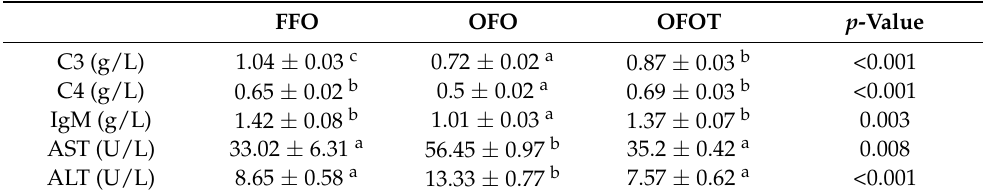
Table 6. Effects of dietary taurine on serum immune indices of channel catfish ( Ictalurus punctatus ) fed oxidized-fish-oil diets.